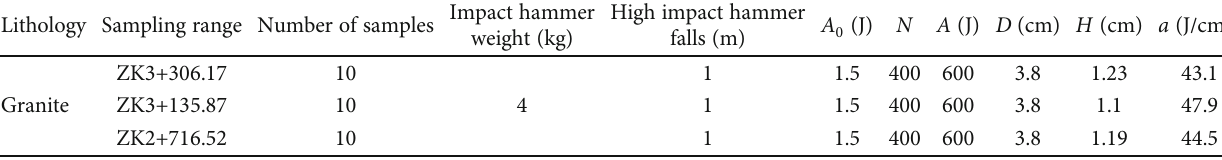
Figure 2: Regional geological map. 1: buried fault; 2: thrust fault; 3: normal fault; 4: strike-slip fault; 5: main fault number; 6: geological boundary; 7: Quaternary. Fault: ① Cangkou fault, ② Pishikou fault, ③ Wangjiage fault, ④ South Chaolian Island fault. < 1 > : early-middle Pleistocene buried faults; < 2 > : pre-Quaternary buried faults; < 3 > : Quaternary; < 4 > : Mesozoic; < 5 > : Proterozoic; < 6 > : Mesozoic intrusions (medium acid); < 7 > : the tunnel route. Fault: (1) Cangkou fault, (2) Xin Island fault, (3) Licang District Government-Huiquanjiao fault, (4) South Tuan Island fault, (5) North Xuejia Island fault. Table 1: Table of test results of granite speci fi c energy of chiseling.